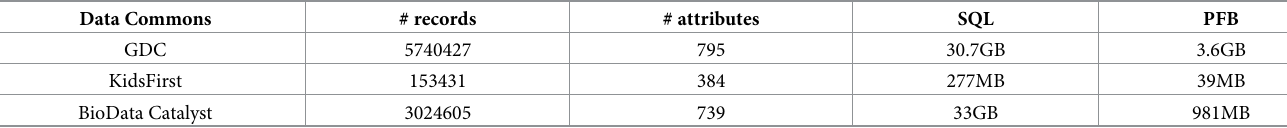
Table 5. Size comparison of existing commons between SQL dump and PFB dump.